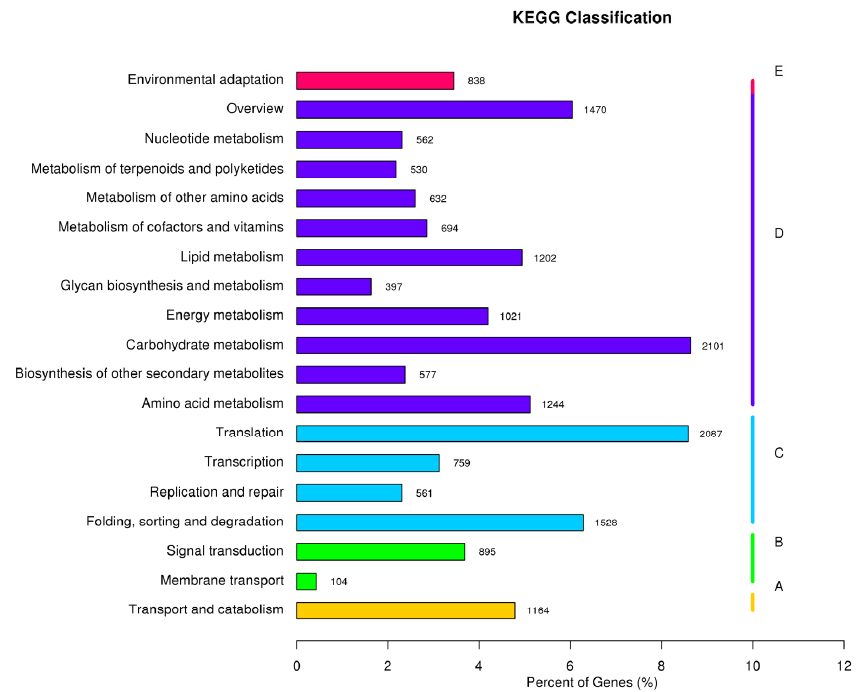
Figure 3. Kyoto encyclopedia of genes and genomes (KEGG) annotation of putative proteins. The x -axis indicates the percentage of the number of genes annotated to the pathway out of the total number of genes annotated. The y ‐ axis indicates the name of the KEGG metabolic pathway. The genes were divided into five branches according to the KEGG metabolic pathway: Cellular Processes (A), Environmental Information Processing (B), Genetic Information Processing (C), Metabolism (D) and Organismal Systems (E).